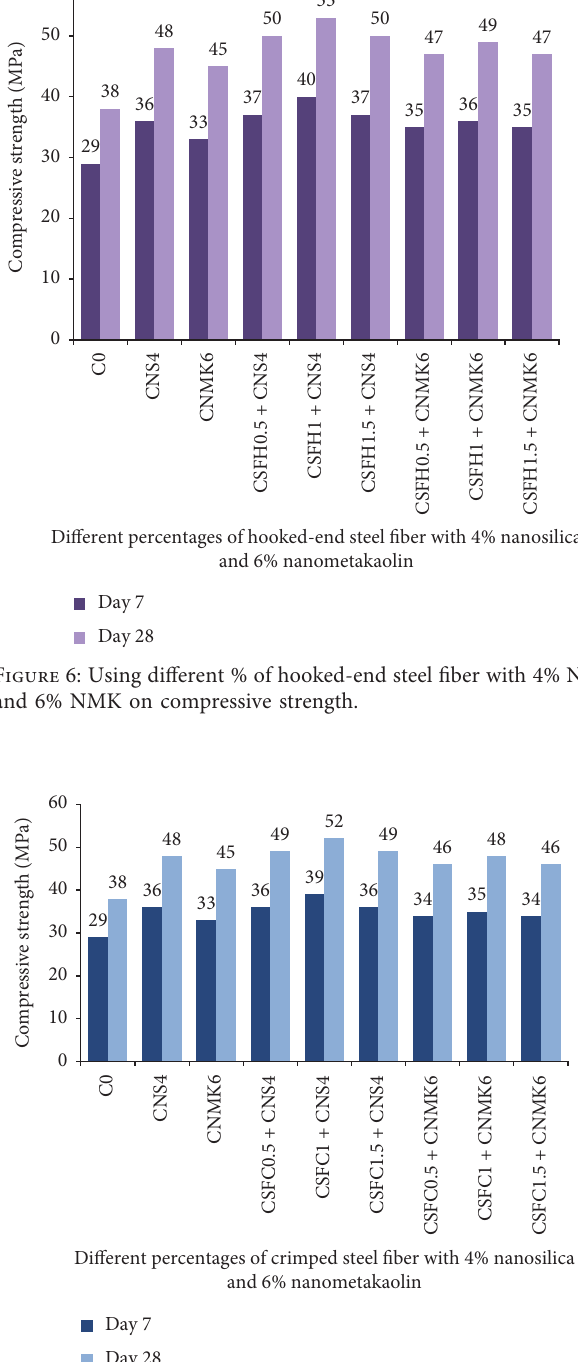
Figure 7: Using different % of crimped steel fiber with 4% NS and 6% NMK on compressive